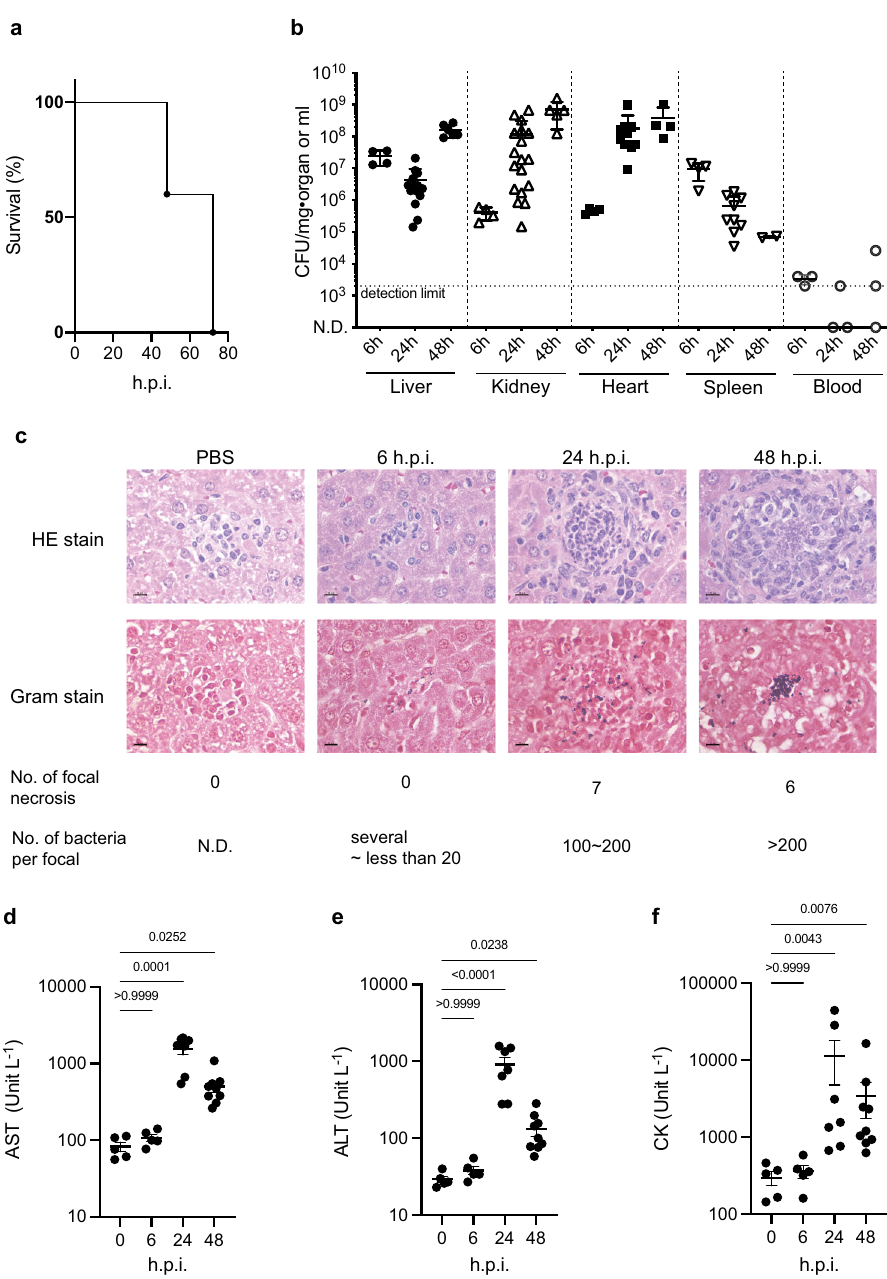
that mapped uniquely on the mouse genome (Supplementary Data 2) and selected genes with a signi fi cant 5-fold difference (false discovery rate [FDR] p -value < 0.05) in liver infected with S. aureus compared with liver injected with phosphate-buffered saline (PBS) to perform the GO term enrichment analysis (Reactome, Supplementary Data 3). The results suggested that genes involved in the induction of innate immunity and in fl am- mation, and those related to metal sequestration were